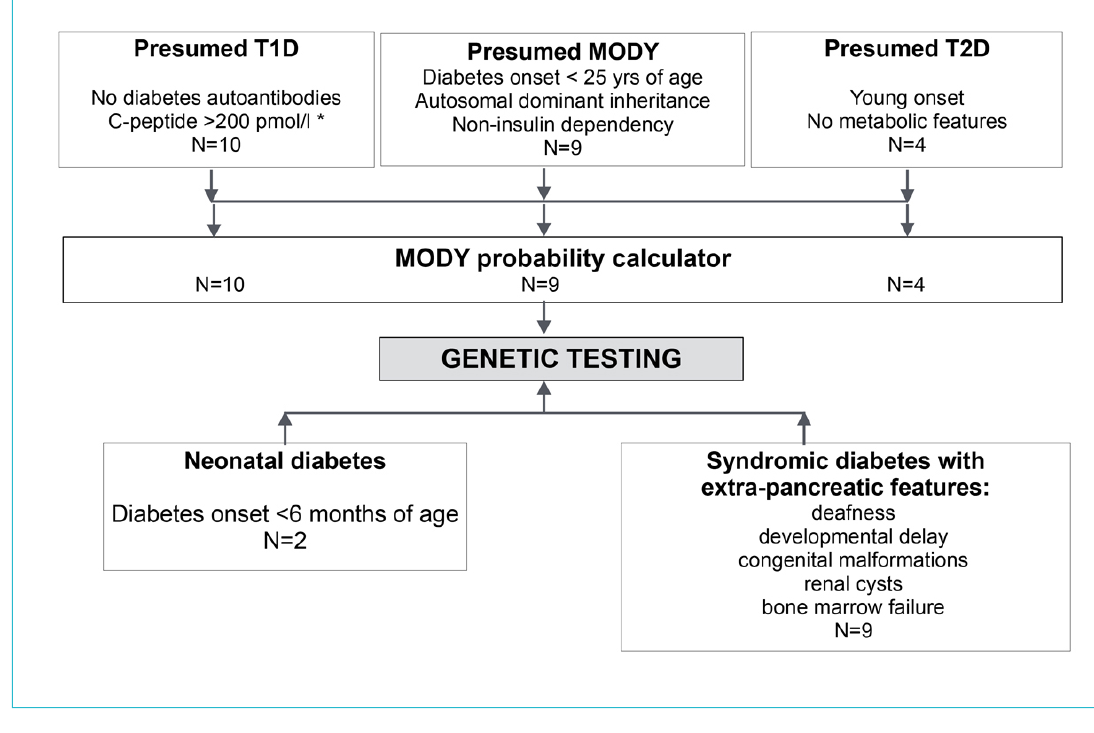
Table 5: DNA used for the validation of the diagnostic gene